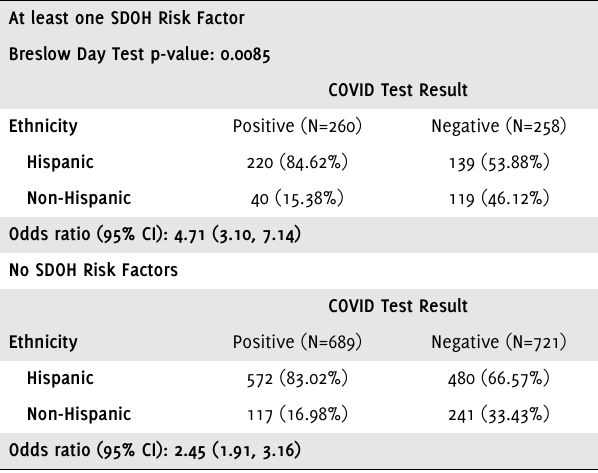
Table 3. Association Between Ethnicity and COVID-19 Status Stratified by SDOH Risk Factor At least one SDOH Risk Factor